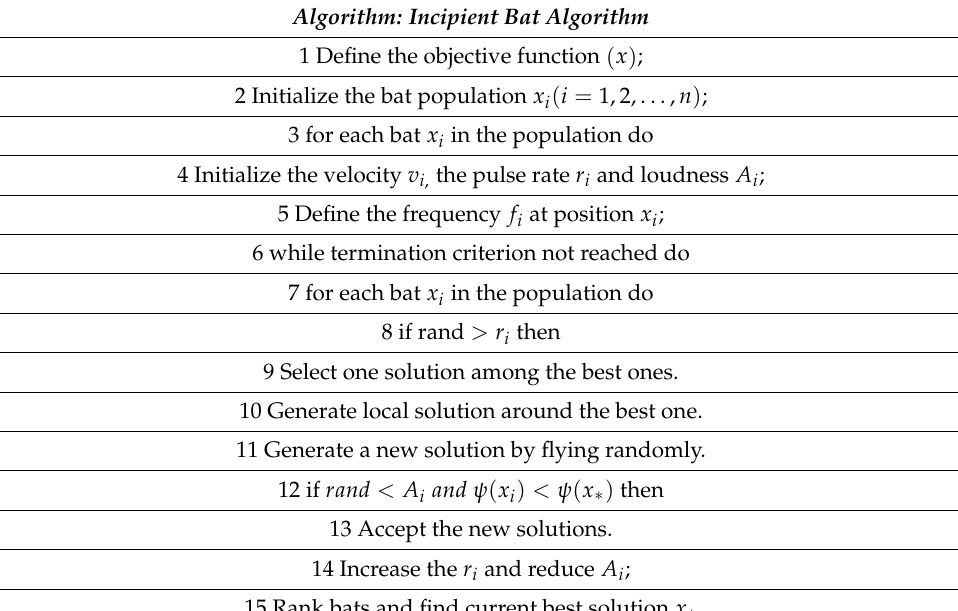
Table 4. Enchased MPA—Incipient Bat Algorithm. Algorithm: Incipient Bat